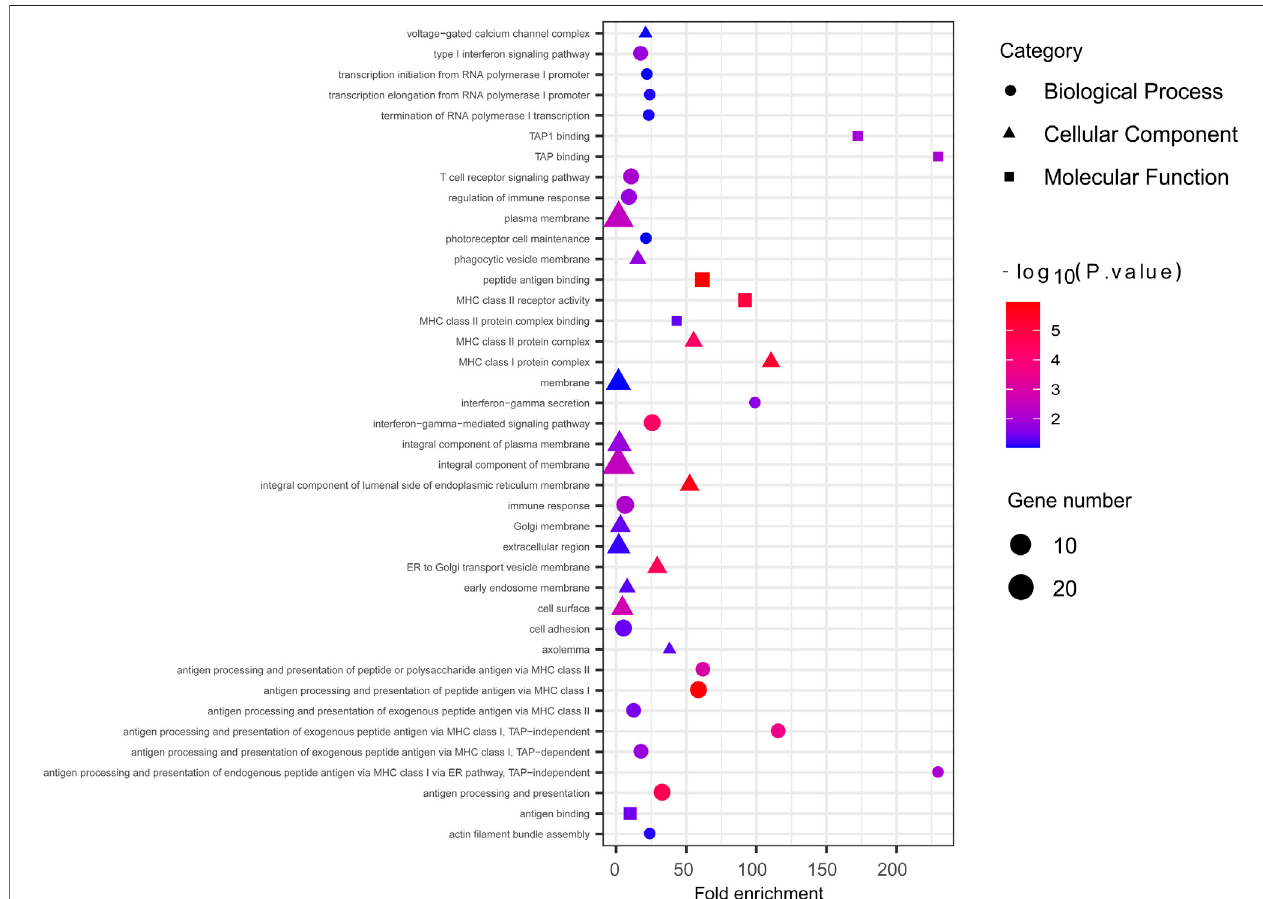
FIGURE 6 | The GO enrichment analysis of Mongolian showed genes with signi fi cant natural signal were mostly enriched in membrane-associated cellular component.